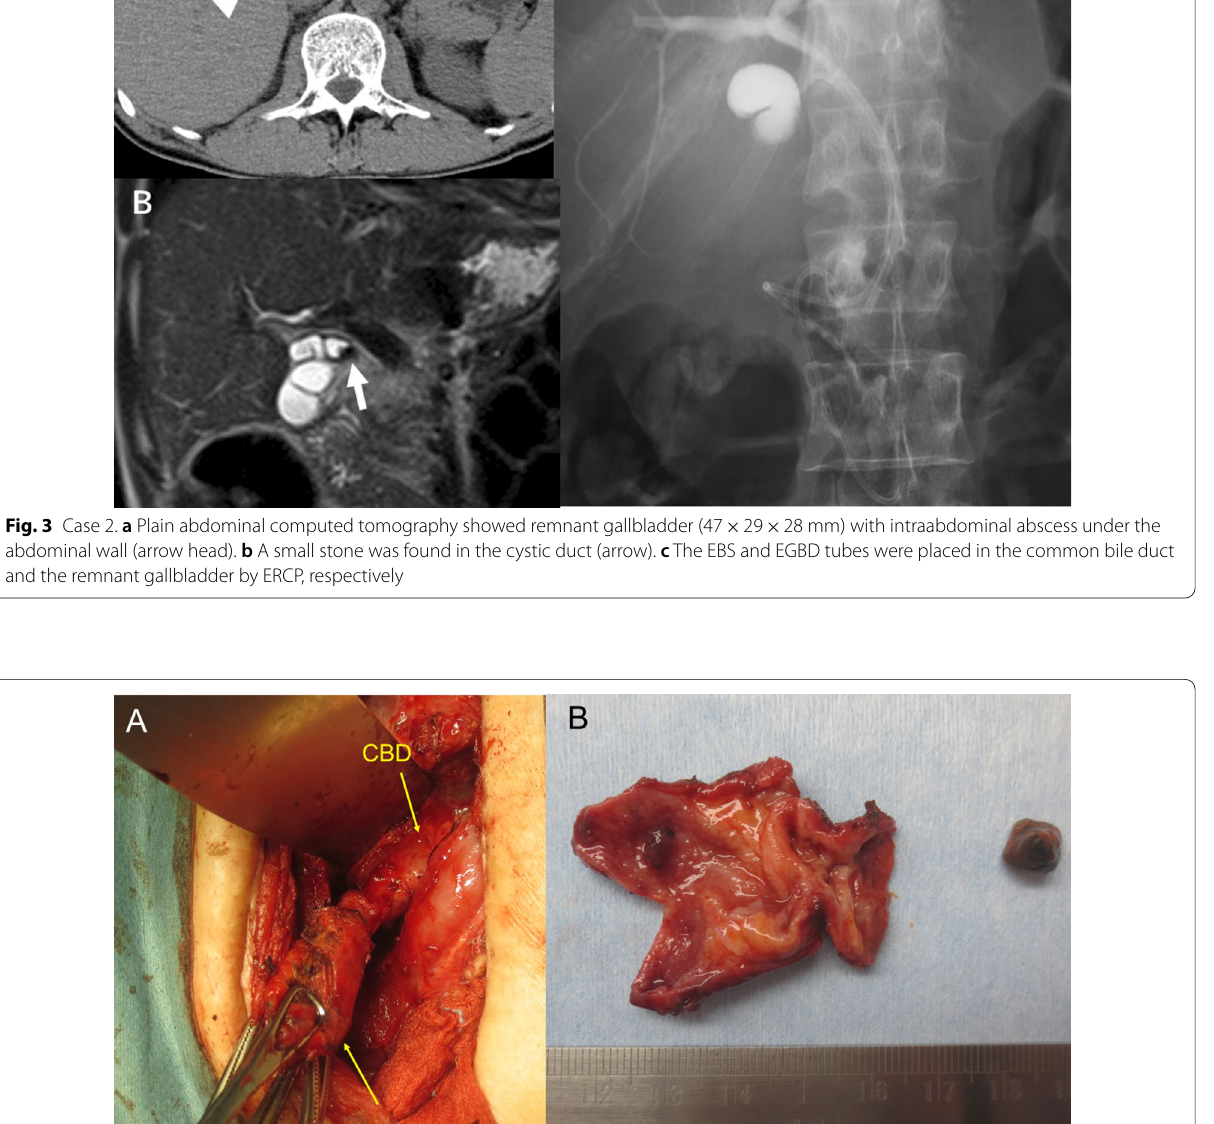
Fig. 4 Intraoperative images of case 2. a Intra-operative image. The remnant gallbladder was separated from the surrounding tissue and common bile duct. b Specimen photography. There was no evidence of malignancy in the remnant